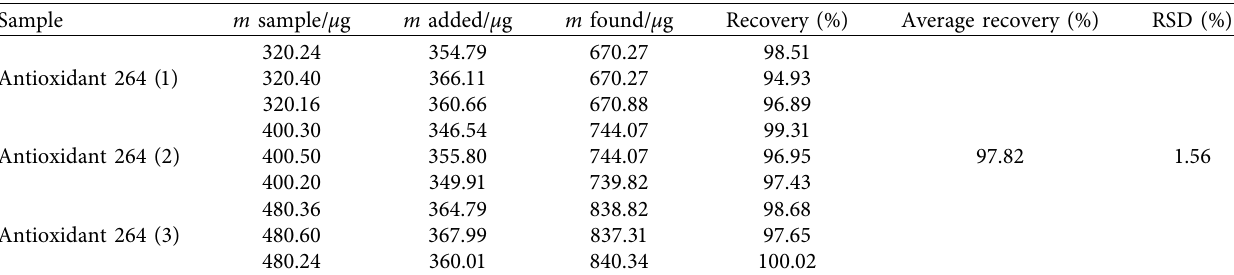
Table 1: Recovery of antioxidant 264 from the rubber stopper.